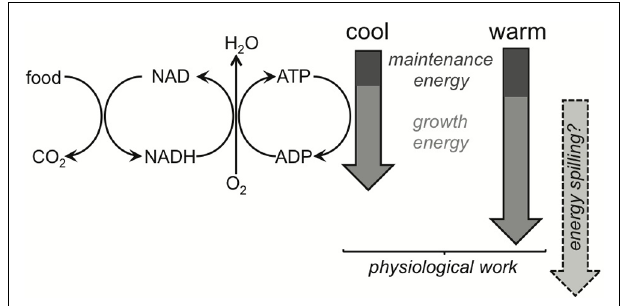
FIGURE 6 | Simplified schematic of metabolism, highlighting ATP-supply being driven by the demand of physiological work and/or energy spilling. Organisms catabolize substrates to provide energy demanded by maintenance and growth. Catabolism and anabolism are then coupled under this metabolic scheme. Decreases in microbial growth efficiency (MGE) are expected under warming, and the commonly cited mechanism involves maintenance energy demands responding more strongly to warming than growth energy demands.The theoretical basis for this expectation remains to be demonstrated and MGEs in field soils can be invariant to temperature. Maintenance demands more likely increase proportionally with growth demands (shown by the cool and warm block arrows), and if temperature accelerates growth then maintenance costs might even become proportionally smaller, increasing MGEs. Energy spilling is an alternative explanation for the uncoupling of catabolism and anabolism under warming. Its direct temperature response is uncertain (depicted by the question mark) but we know it does respond strongly to substrate